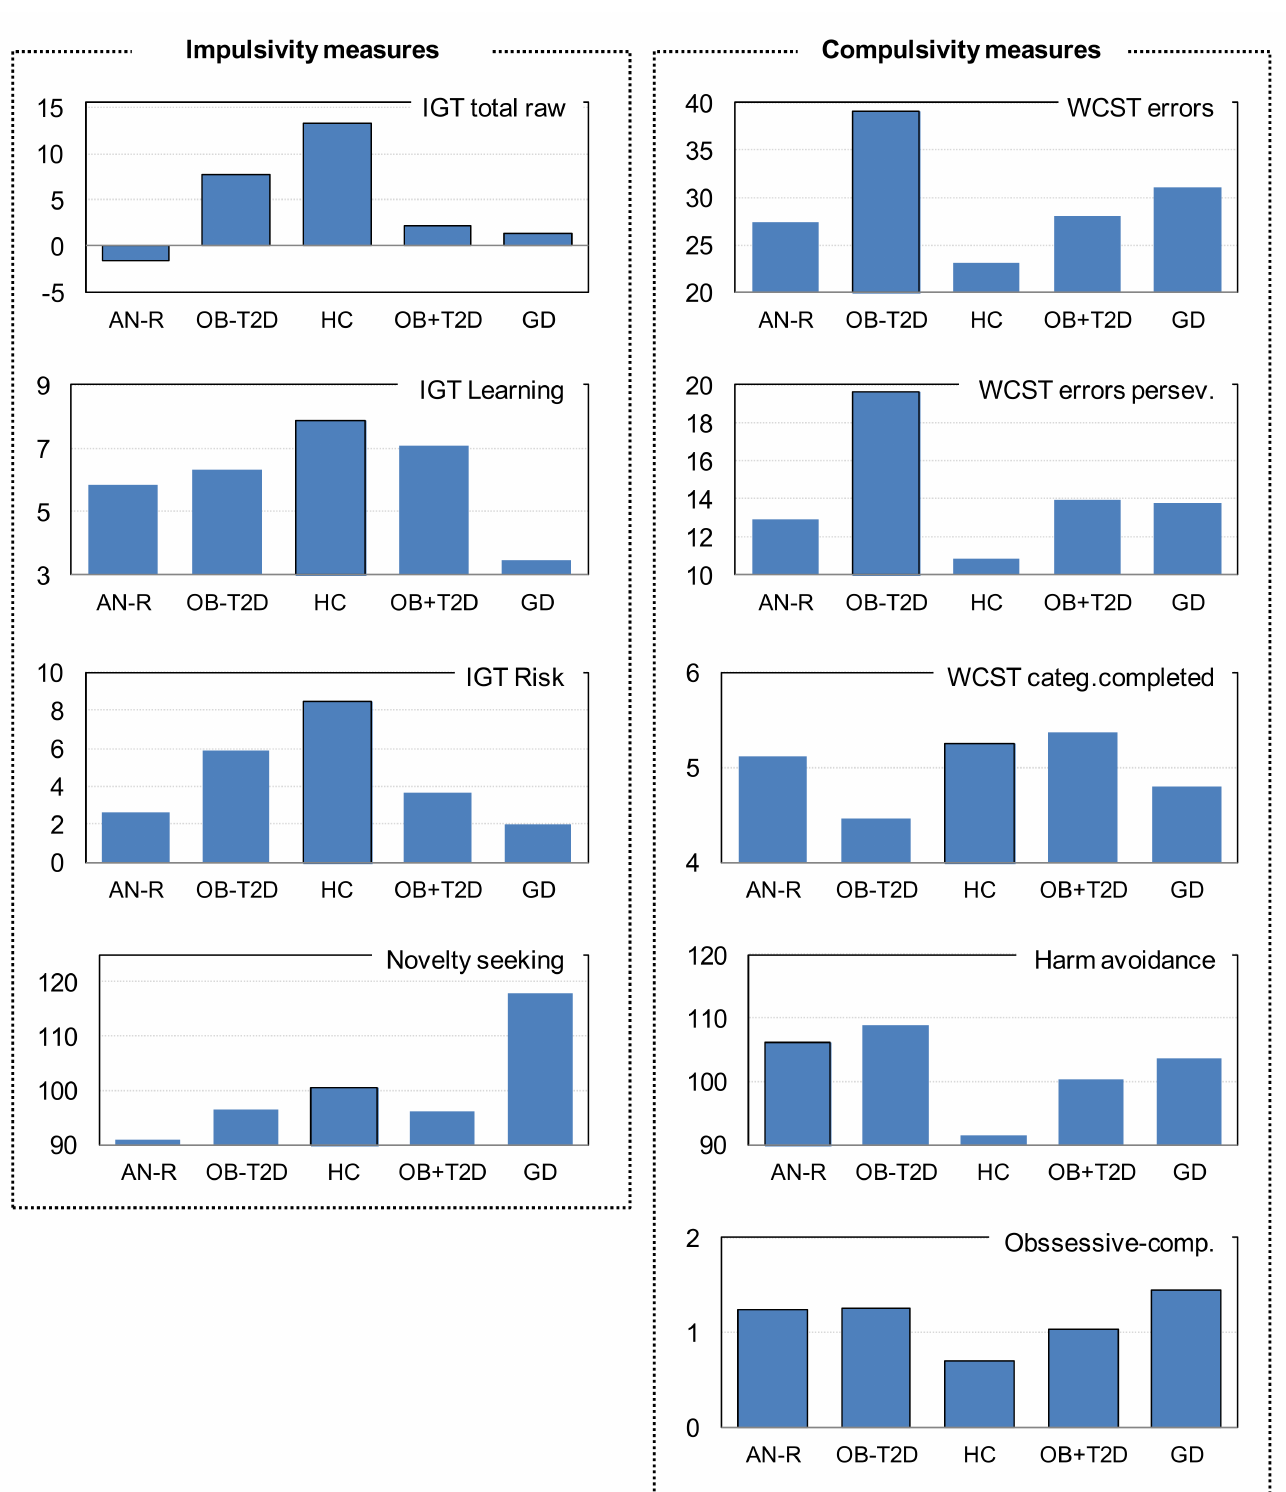
Figure 1. Bar charts with the impulsivity–compulsivity measures in the study (dimensional